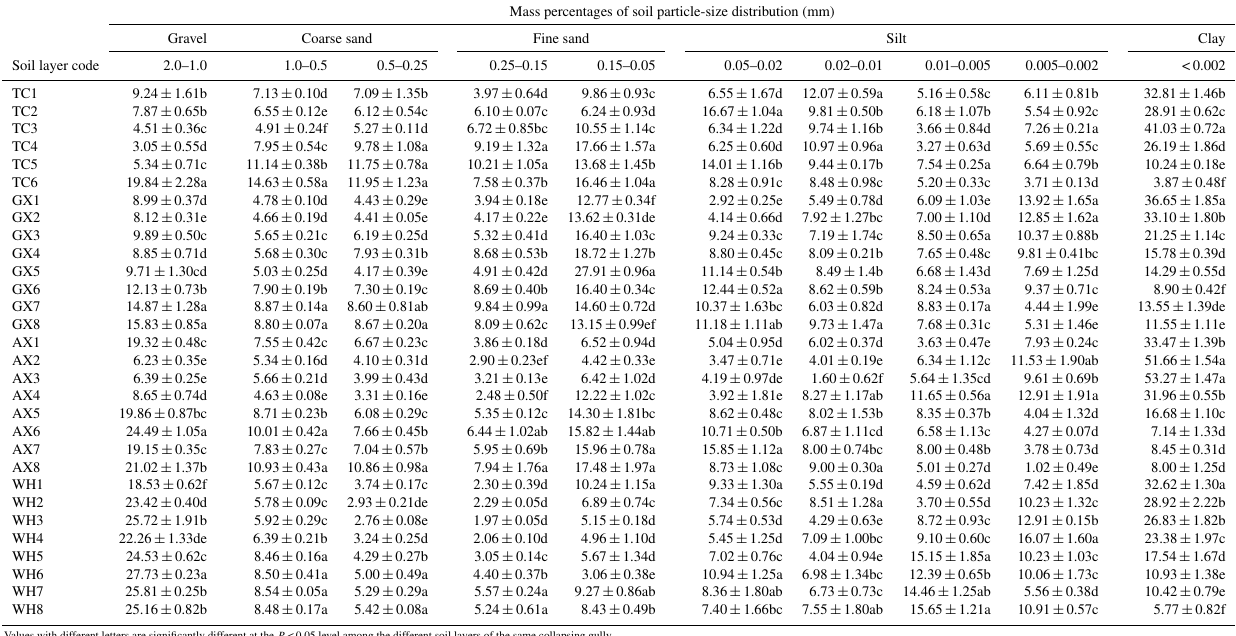
Table 3. Percentages of different particle-size distributions of different weathering profiles of the four collapsing